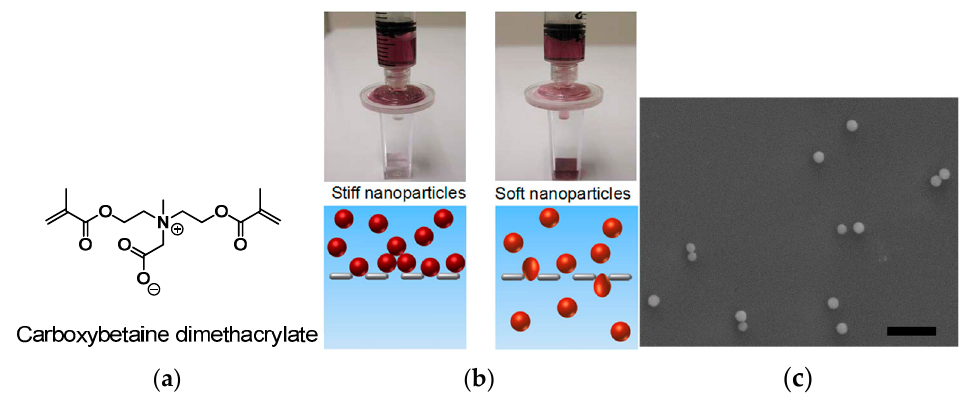
Figure 14. Zwitterionic stiff/soft nanogel: ( a ) Structure of the zwitterionic crosslinker; ( b ) a simple filtration reveal the qualitatively different behavior of the two nanogels; and ( c ) scanning electron microscopy image of the soft nanogel particles (scale bar = 1 μ m). Reprinted with permission from Reference [84]. Copyright 2012 American Chemical Society.